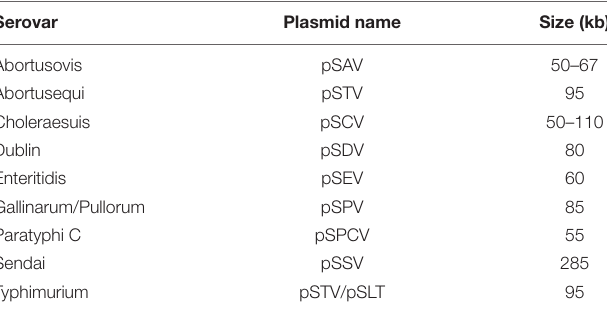
TABLE 2 | Selected nontyphoidal and paratyphoidal virulence plasmids.